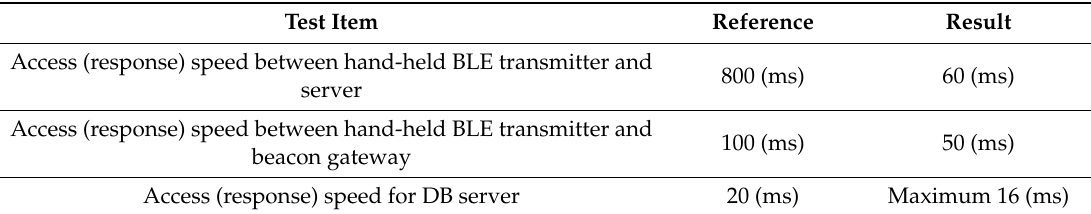
Table 3. Test item, reference, and their results.